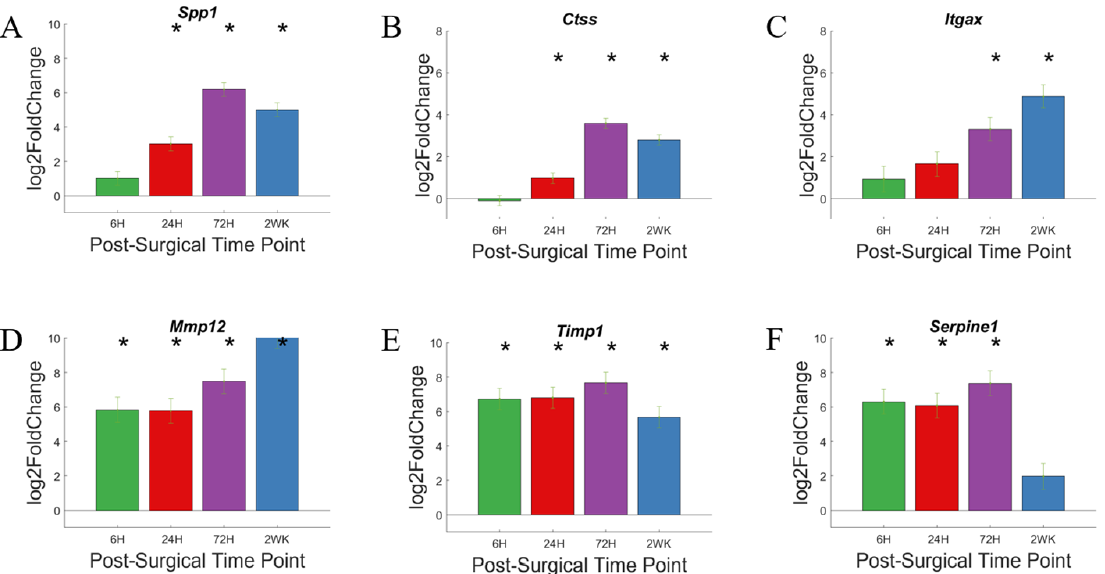
Figure 14. Differential expression of specific genes involved in the extracellular matrix pathway compared to NSCTR mice ( A – F ) Top differentially expressed genes for the extracellular matrix gene set displayed as bar graphs of individual genes as a function of time post-surgery. For each time point, gene expression levels are compared to the NSCTR mice. Error bars indicate the standard error of the mean between NSCTR and each time point. Asterisks indicate that P adj < 0.05. Note ( A , D , E , F ) which depicts the upregulation of Spp1 , Mmp12 , Timp1 , and Serpine1 , respectively, has a y-axis log2foldchange scale of − 1 to 10, because of their high